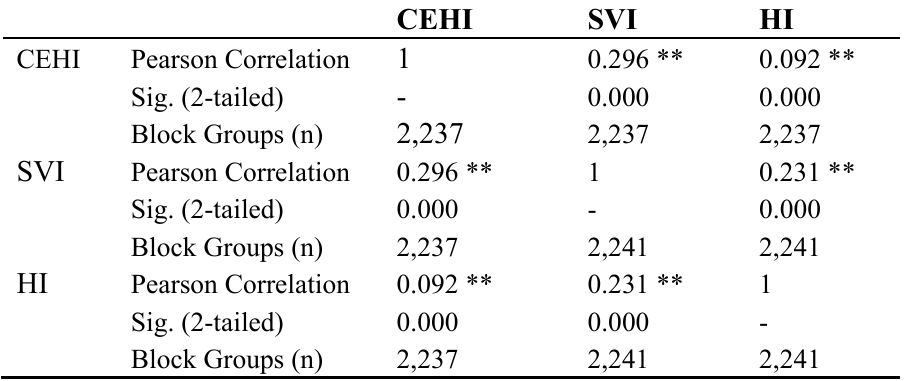
Table 2. Pearson’s Correlation Matrix of CEHI, SVI and HI.